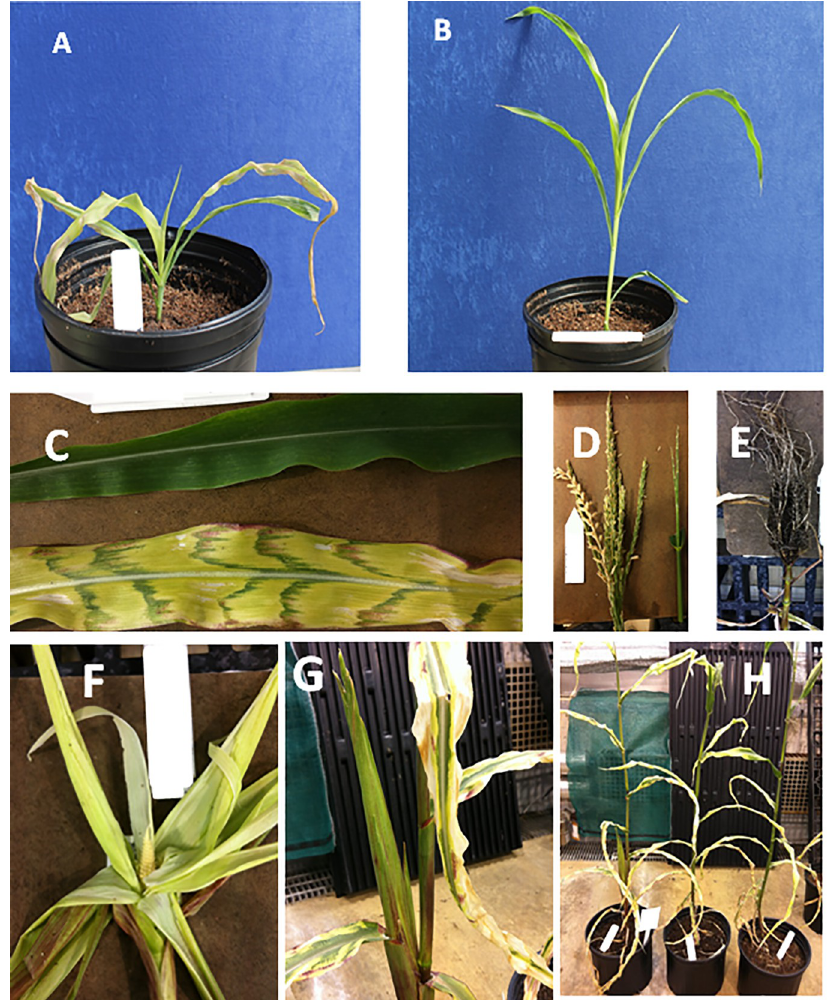
Fig 2. Growth deformities in AtGAD1- Δ CaMD plant expressed under RTBV promoter A. A: 30-day-old AtGAD1- Δ CaMD; B: 30-day-old wild-type, C : 150-day-old leaf of wild-type; 150-day-old leaf of AtGAD1- Δ CaMDt; D: 150-day- old tassel of AtGAD1- Δ CaMD; E: 150-day-old root of AtGAD1- Δ CaMD; F: 150-day-old ear of AtGAD1- Δ CaMD plant; G: 150-day-old ear of AtGAD1- Δ CaMD; H: 150-day AtGAD1- Δ CaMD entire plant. 3.3-fold reduction in GABA levels and a 4-fold lower GAD enzyme activity was observed in the GAD5 suppression line (Figs 5 and 6). Suppression of GABA transporter gene expression was not found to decrease GABA levels or GAD activity, under the conditions tested in this study (Figs 5 and 6), and had no perturbation of the amino acid levels except for 2-3-fold higher levels of Asn in biosynthetic suppression lines compared to the WT.